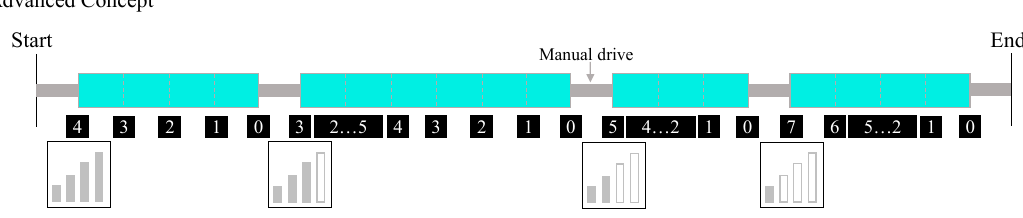
Figure 3. Exemplary experimental drive (periods with available automation are cyan, dotted lines represent 1 min). Black boxes with white numbers are durations displayed in the predictive HMI (leaps are displayed with “ ... ”, e.g., 2 ... 5). Confidence levels at the start of each automated driving period are displayed on the bottom. After a leap, the confidence level was set to 100% and remains 100% until the end of the automated driving section.